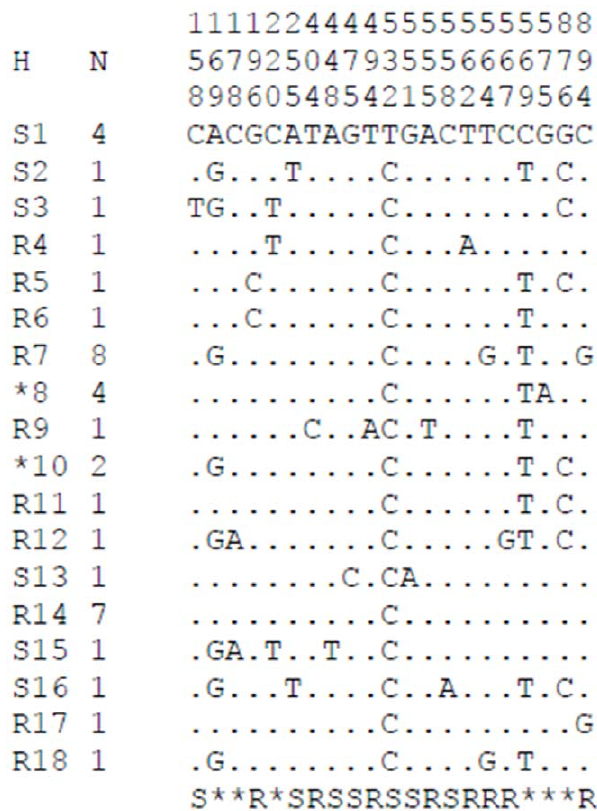
Figure 3. Schematic representation of haplotypes (H) of the 917 bp portion of the Voltage-gated sodium channel gene (VGSC) observed in the Tororo population. Only polymorphic sites are shown and these are numbered from the beginning of the 917 bp sequence. Dots mean identity with the first sequence. A number has been given to each haplotype preceded by the letter R or S if it is unique to the resistant or susceptible sample respectively. In case of a shared haplotype, the number is preceded by an asterisk. The column (N) indicates the number of individuals sharing the haplotype. Below the list of haplotypes, R or S indicates the positions that are polymorphic in the resistant or susceptible mosquitoes respectively, while an asterisk marks a position polymorphic in both phenotypes.